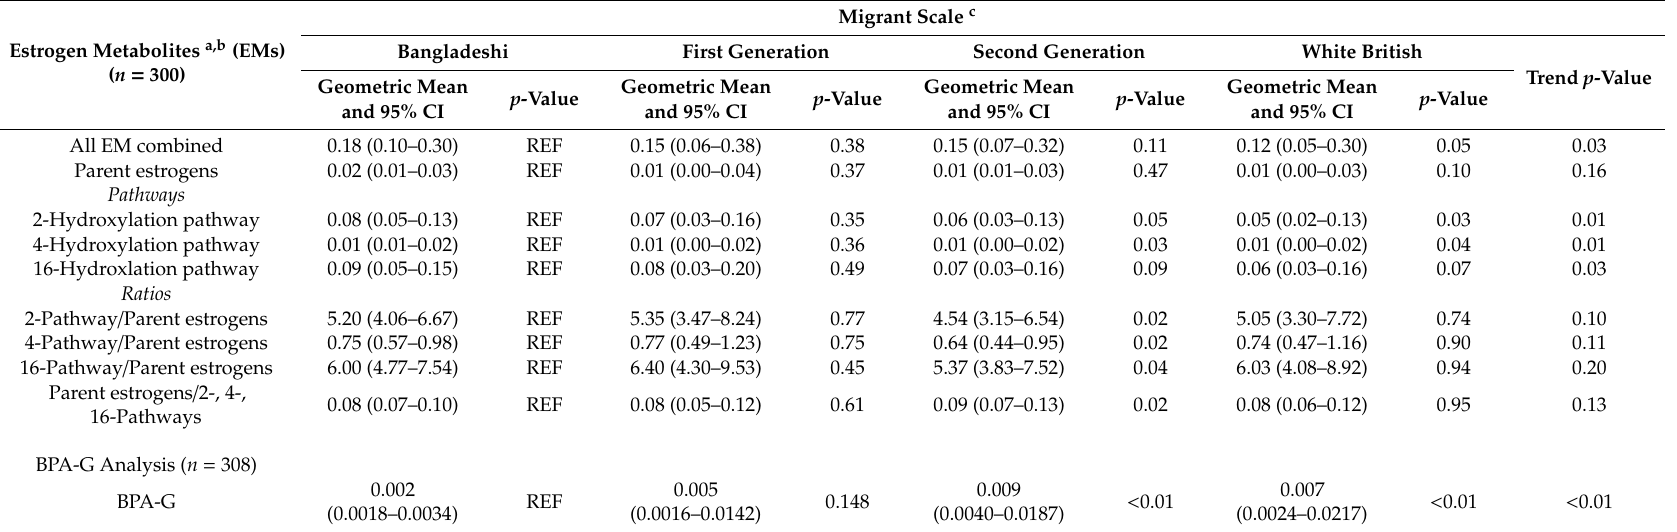
Table 2. Mean concentration of urinary estrogen metabolites (ng / mg creatinine) and Bisphenol-A-glucuronide (ng / mg creatinine) by migrant scale among British and Bangladeshi girls 5–16 years of age, ABBY